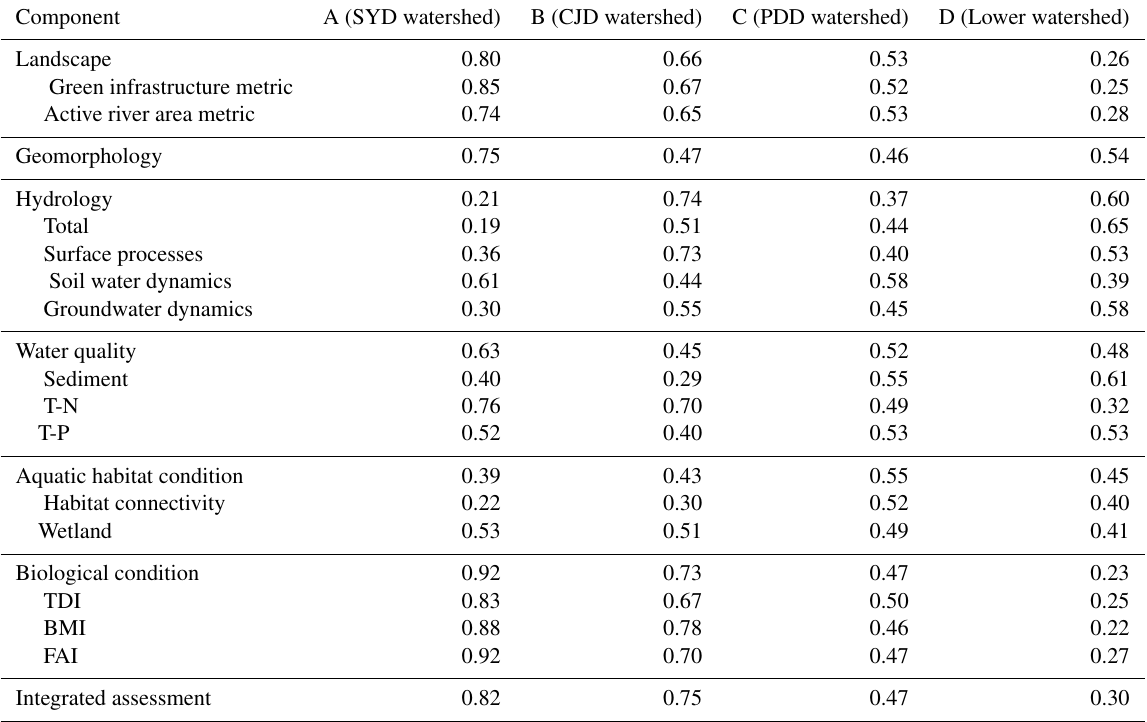
Table 5. Watershed-health score results in each test area (upper/lower stream) of the Han River basin. Component A (SYD watershed) B (CJD watershed) C (PDD watershed) D (Lower watershed) Landscape 0.80 Green infrastructure metric 0.85 Active river area